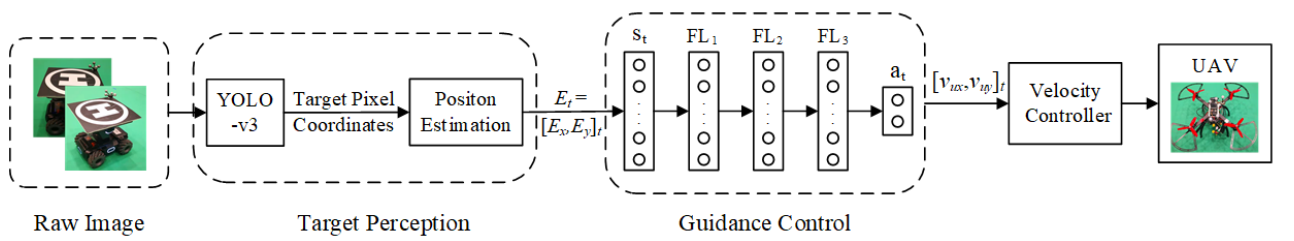
Figure 2. The integrated controller framework for UAV tracking target based on multi-neural-network modules (MNNMs).